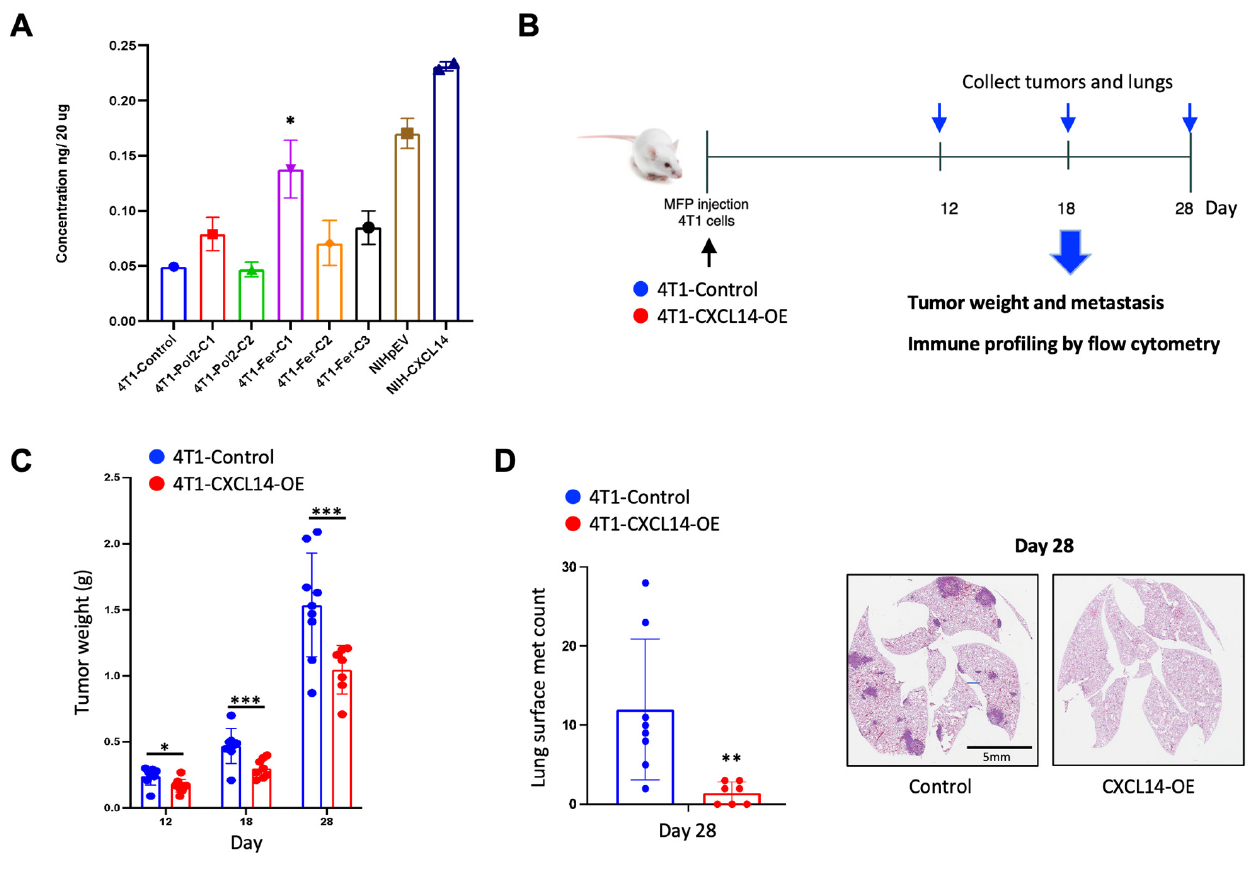
Figure 3. Effects of CXL14 overexpression on tumor growth and metastasis in 4T1 orthotopic model of spontaneous metastasis. ( A ) CXCL14 protein levels in generated CXCL14 overexpression (OE) 4T1 cell clones and NIH-fibroblast cells by ELISA. * indicates 4T1-CXCL14-OE cells selected for an in vivo study. ( B ) Experiment design for in vivo study to investigate the functional role of CXCL14 on TNBC progression. ( C ) Comparison of tumor weights in mice bearing 4T1-control and CXCL14-OE 4T1 cells, at day 12, 18, and 28 after cancer-cell injection ( n = 6–8). ( D ) Lung metastases in mice bearing 4T1-control and CXCL14-OE 4T1 cells at post-injection day 28 (left panel: n = 7–9) and representative H&E staining images (right panel). Data are presented as mean ± SD. * p < 0.05, ** p < 0.01. *** p < 0.001.